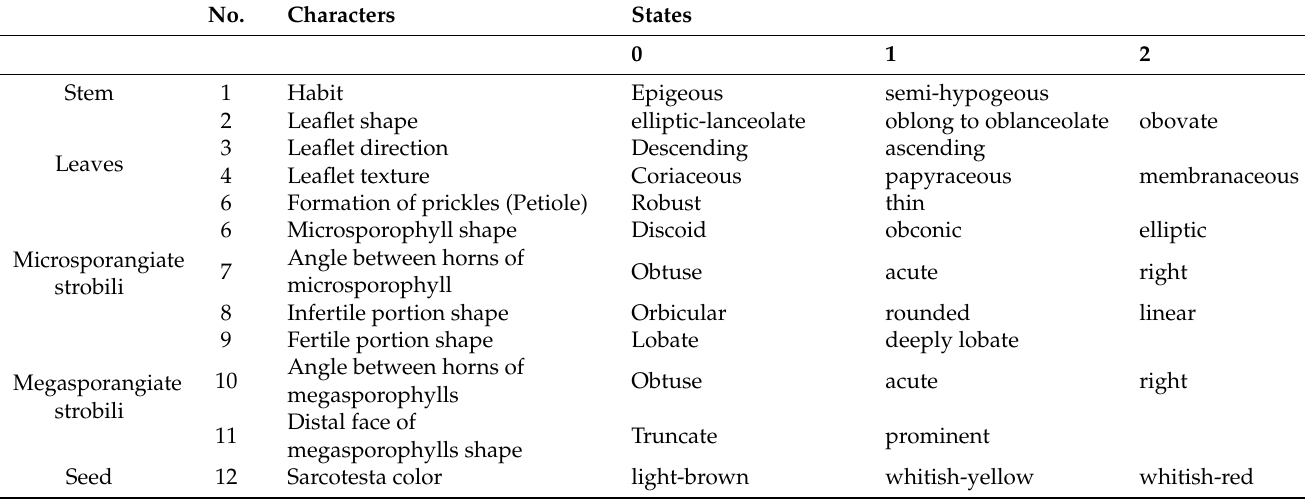
Table 3. List of morphological characters traced on the phylogenetic tree of the genus Ceratozamia